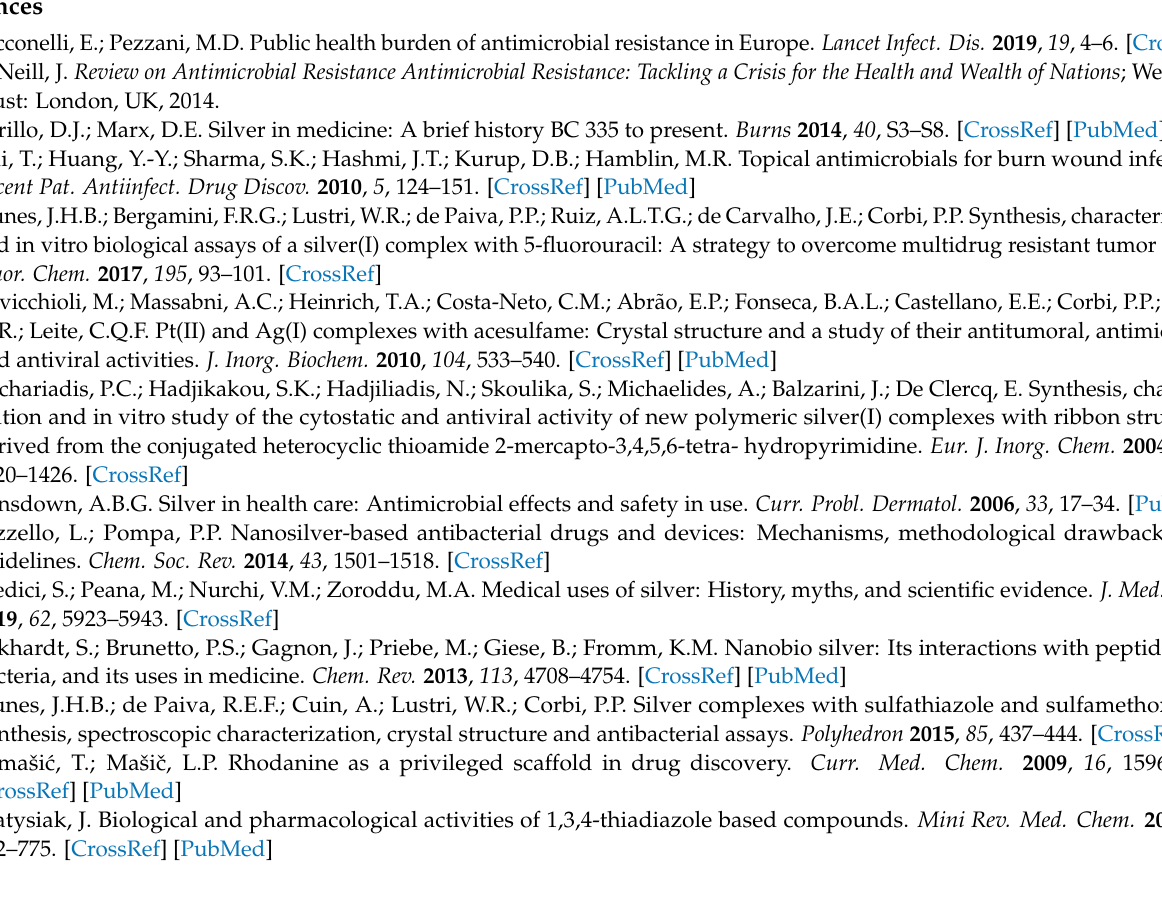
used for figure analysis, Table S1: Details of the crystal structure determination for complexes Ag1 – 3